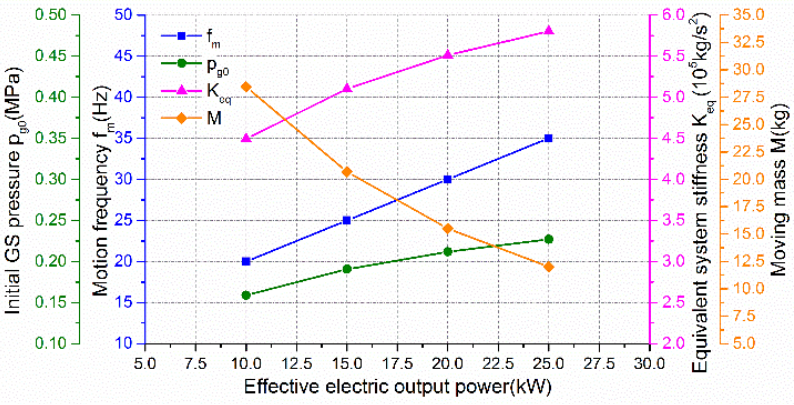
Figure 10. Operational parameters versus effective electric output power map.